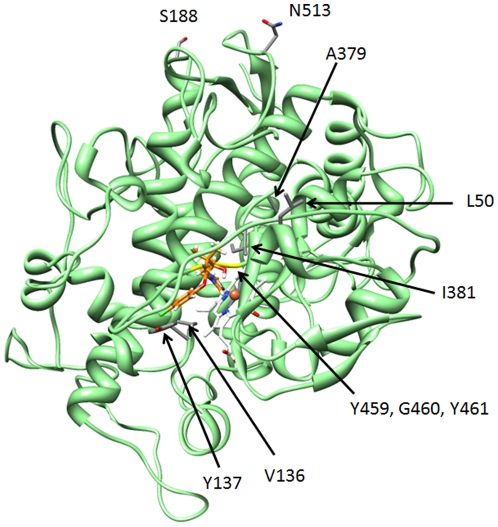
Wild type CYP51.Wild type CYP51 binding triadimenol, showing the location in the wild type protein structure of the residues subject to alteration; I381 and Y137 labelled, V136, in grey, neighbouring Y137, triadimenol in orange and the Y459/G460 region in yellow. The chloride group (green) of triadimenol is predicted to form a weak hydrogen bond with Y137. The I helix of the protein is shown running down the left hand side of the bound azole and the K helix behind I381 extending down behind the haem group. Figure 1 shows the location in the wild type protein structure of the residues subject to alteration. L50 and A379 do not directly border the binding pocket, but form part of secondary structures that are immediately adjacent to the cavity. S188 and N513 are located on the outside of the protein, far removed from the binding regions.